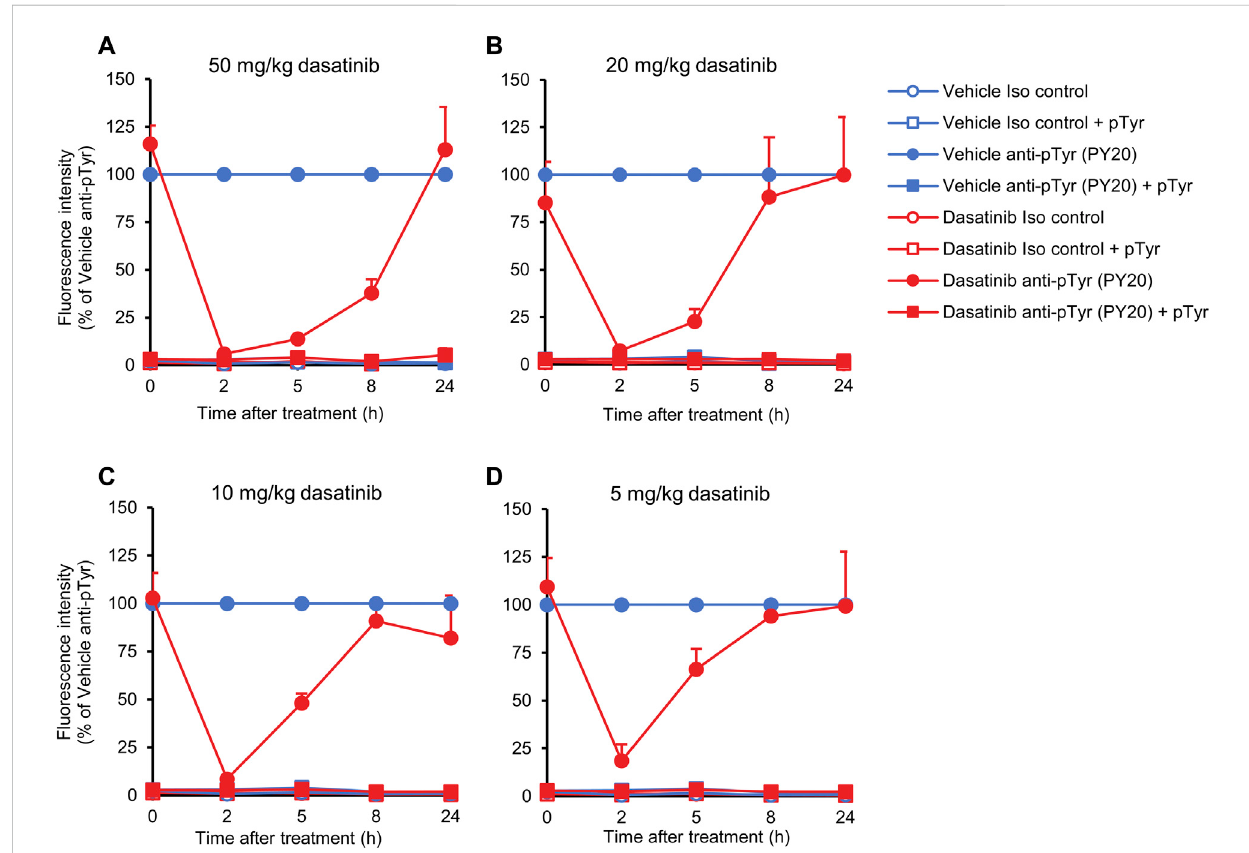
Kineticanalysisoftheeffectofdasatinibtreatment.Wild-typemiceweretreatedwithvehicleoror50 (A) ,20 (B) ,10 (C) ,5 mg/kg (D) dasatinibbyoral gavage.Bloodsampleswereobtainedimmediatelybefore(0timepoint)or2,5,8or24 hlaterandstainedwiththePY20anti-phosphotyrosineantibodies or isotype controls. Where indicated, the anti-phosphotyrosine antibodies were presaturated with 4 mM soluble phosphotyrosine. Geometric mean fl uorescence intensity values obtained from the indicated mice and normalized to those of vehicle-treated samples stained with anti- phosphotyrosineantibodies withoutanypresaturationwiththeirantigensareshown.ThegraphsshowmeanandSEMfrom3-8micepertreatment from at least three independent experiments. SEM values of the normalized isotype control samples (with or without soluble phosphotyrosine pretreatment) were extremely low. pTyr, phosphotyrosine; Iso,